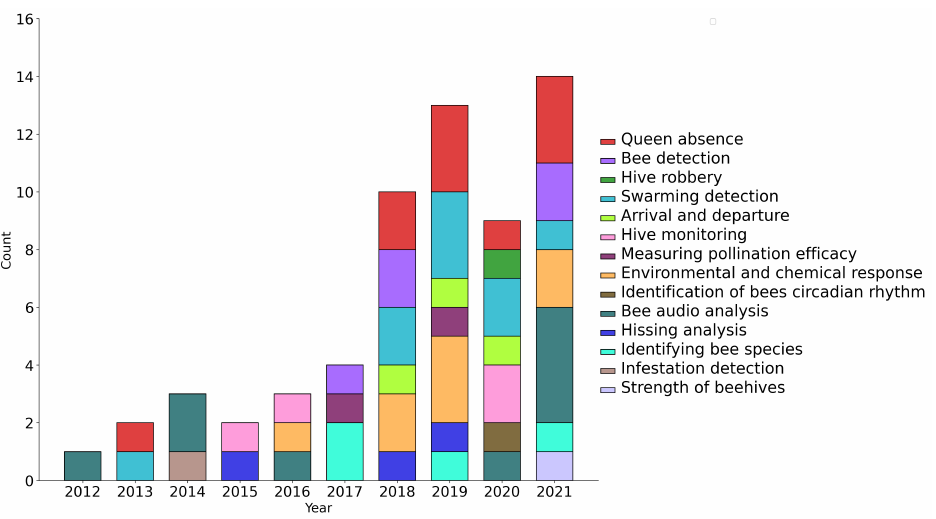
Figure 3. Study goal of articles with respect to the year published.